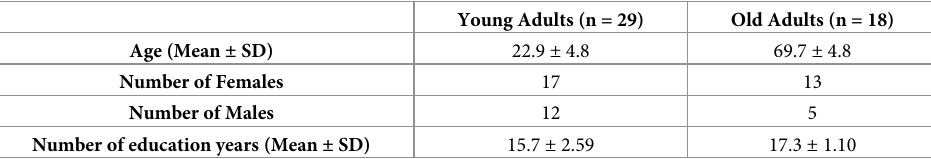
Table 1. Baseline demographics for young and older